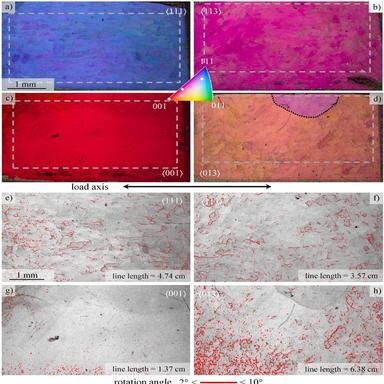
Crystallographic orientation of the compressive specimens in the colors of the inverse pole figure plotted according to the load axis (horizontal). (a)–(c) Single crystals. (d) Specimen with a marked high angle grain boundary within the gauge length (black dotted line). (e)–(h) Low angle grain boundaries highlighted in red with total grain boundary length. Note that (e)–(h) are cropped sections from (a)–(d), (marked by grey dotted boxes) due to the reduced Kikuchi pattern quality at the edges of the specime